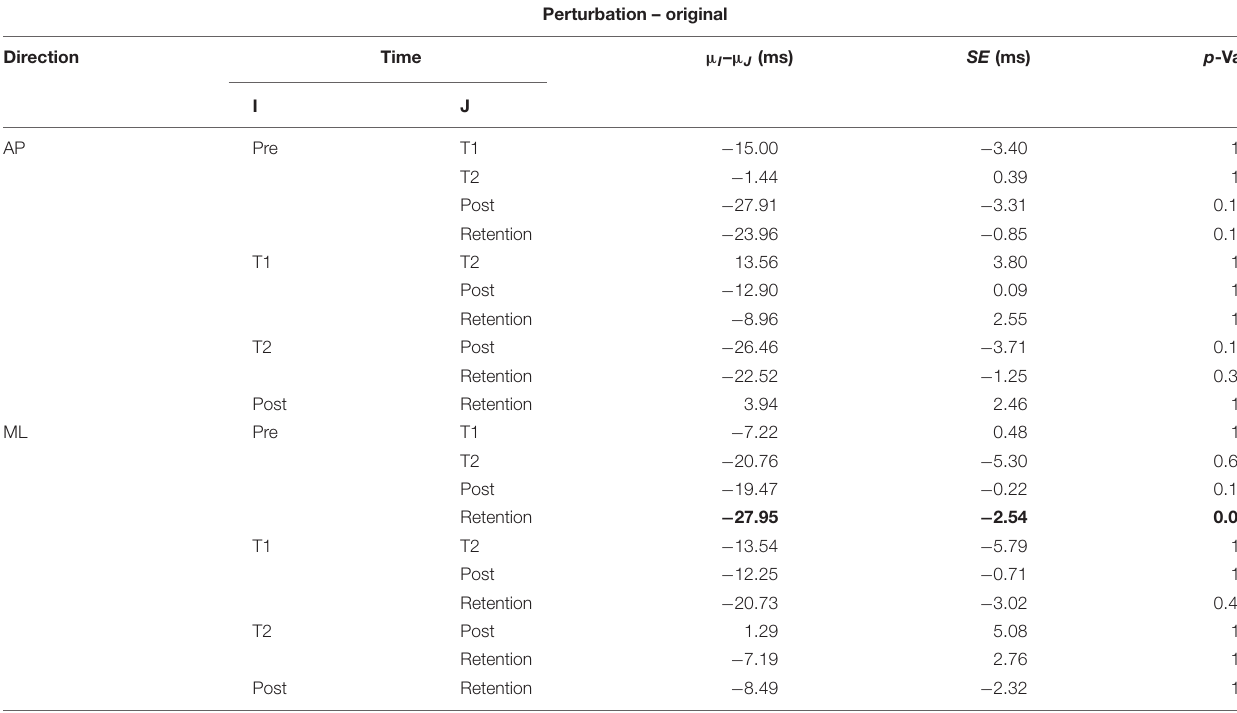
Bold font represents significance at the α ≤ 0.05 level.